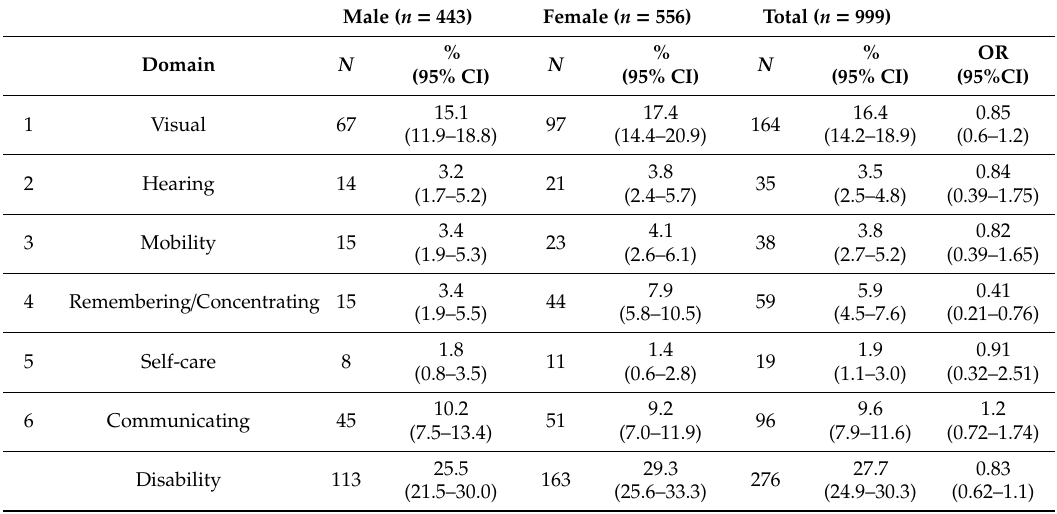
Table 3. Overall and sex-disaggregated rates of six Washington Group functions and of disability.